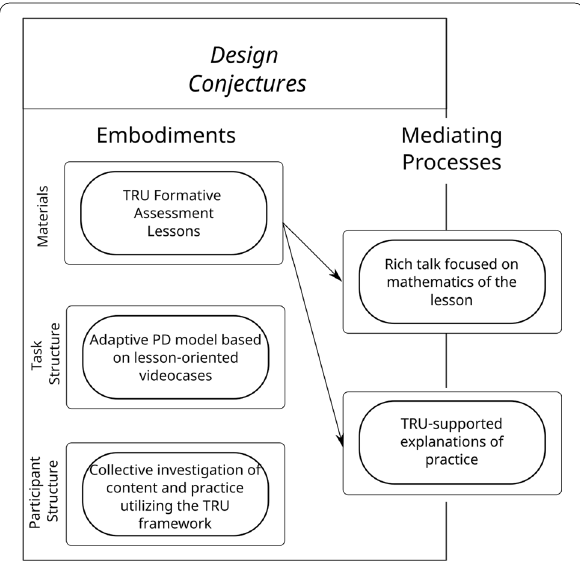
Fig. 6 Elements of the conjecture map that were the focus of the third activity